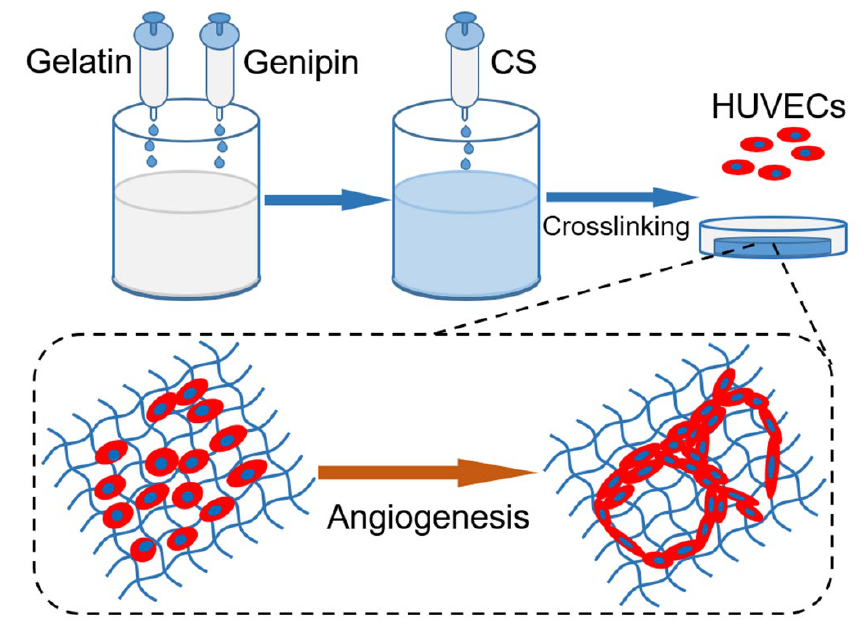
Figure 1. Schematic diagram of functional hydrogel fabrication.